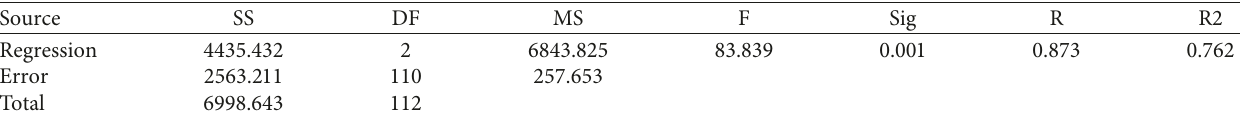
Table 7: The results of the analysis of variance, the multiple correlation coefficient, and the coefficient of determination of the multiple regression model between cognitive failure, psychological flow, and psychological resilience.